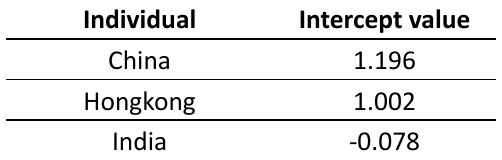
Table 5: Intercept Value of Each